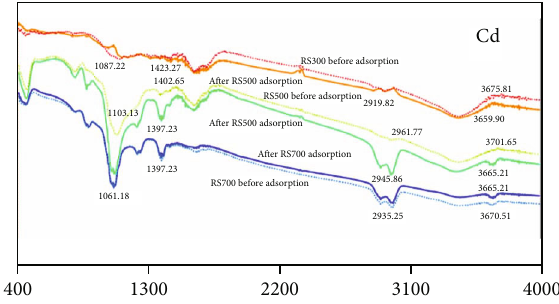
Figure 16: Competitive adsorption mechanism of cadmium on Cd 2+ in acidic